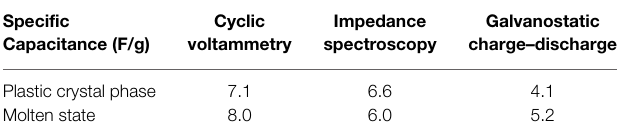
TABLE 1 | Specific capacitance values of the EDLC utilizing the SCN- 10%TBA-PF 6 electrolyte in the plastic phase (15°C) and the molten state (25°C) . Specific Capacitance